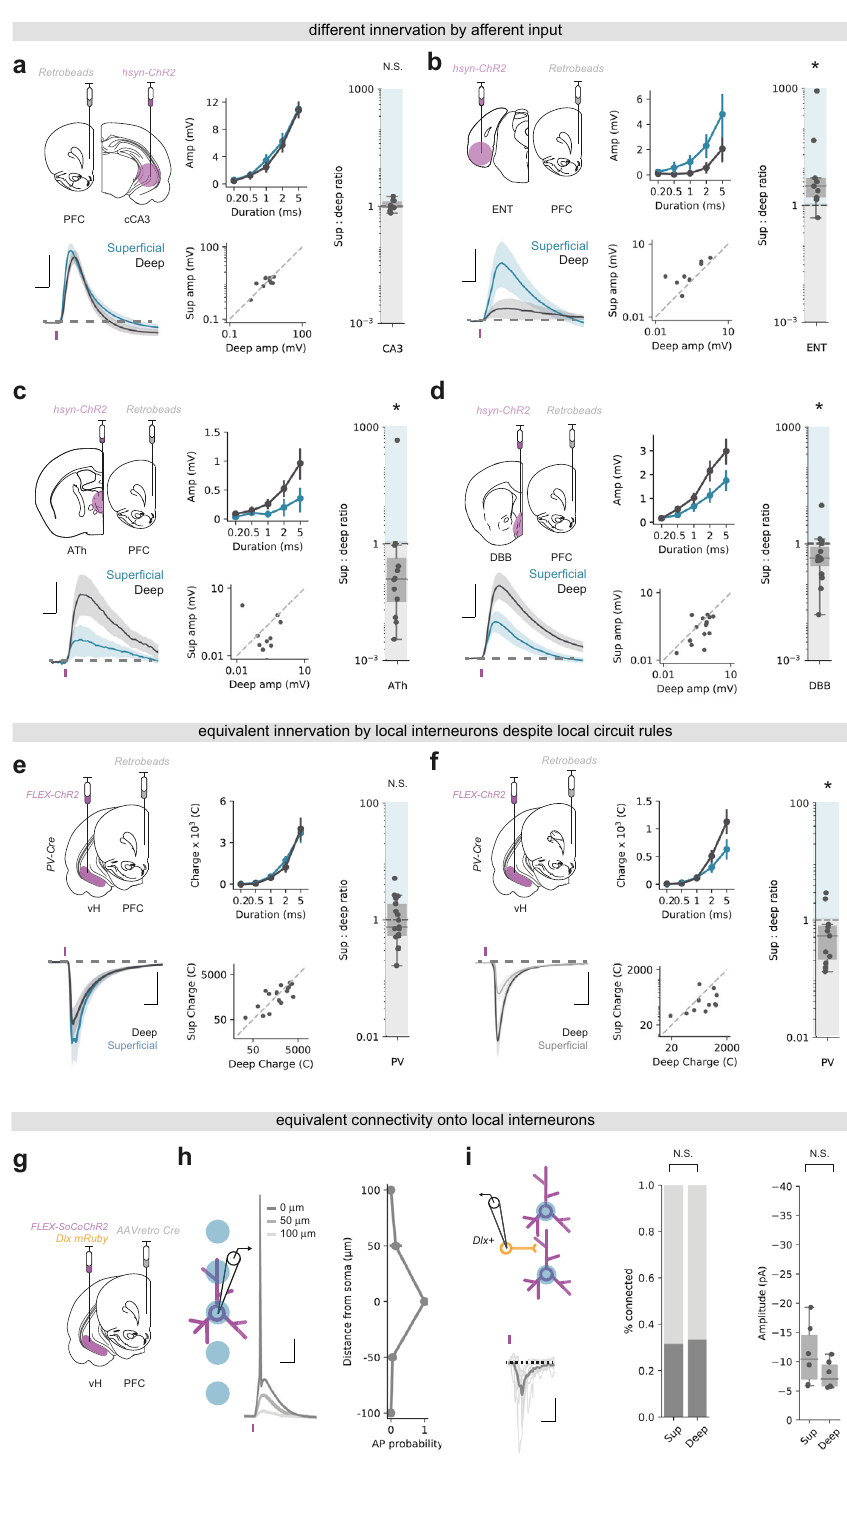
blockers, and used a focused light spot to activate soCoChR2